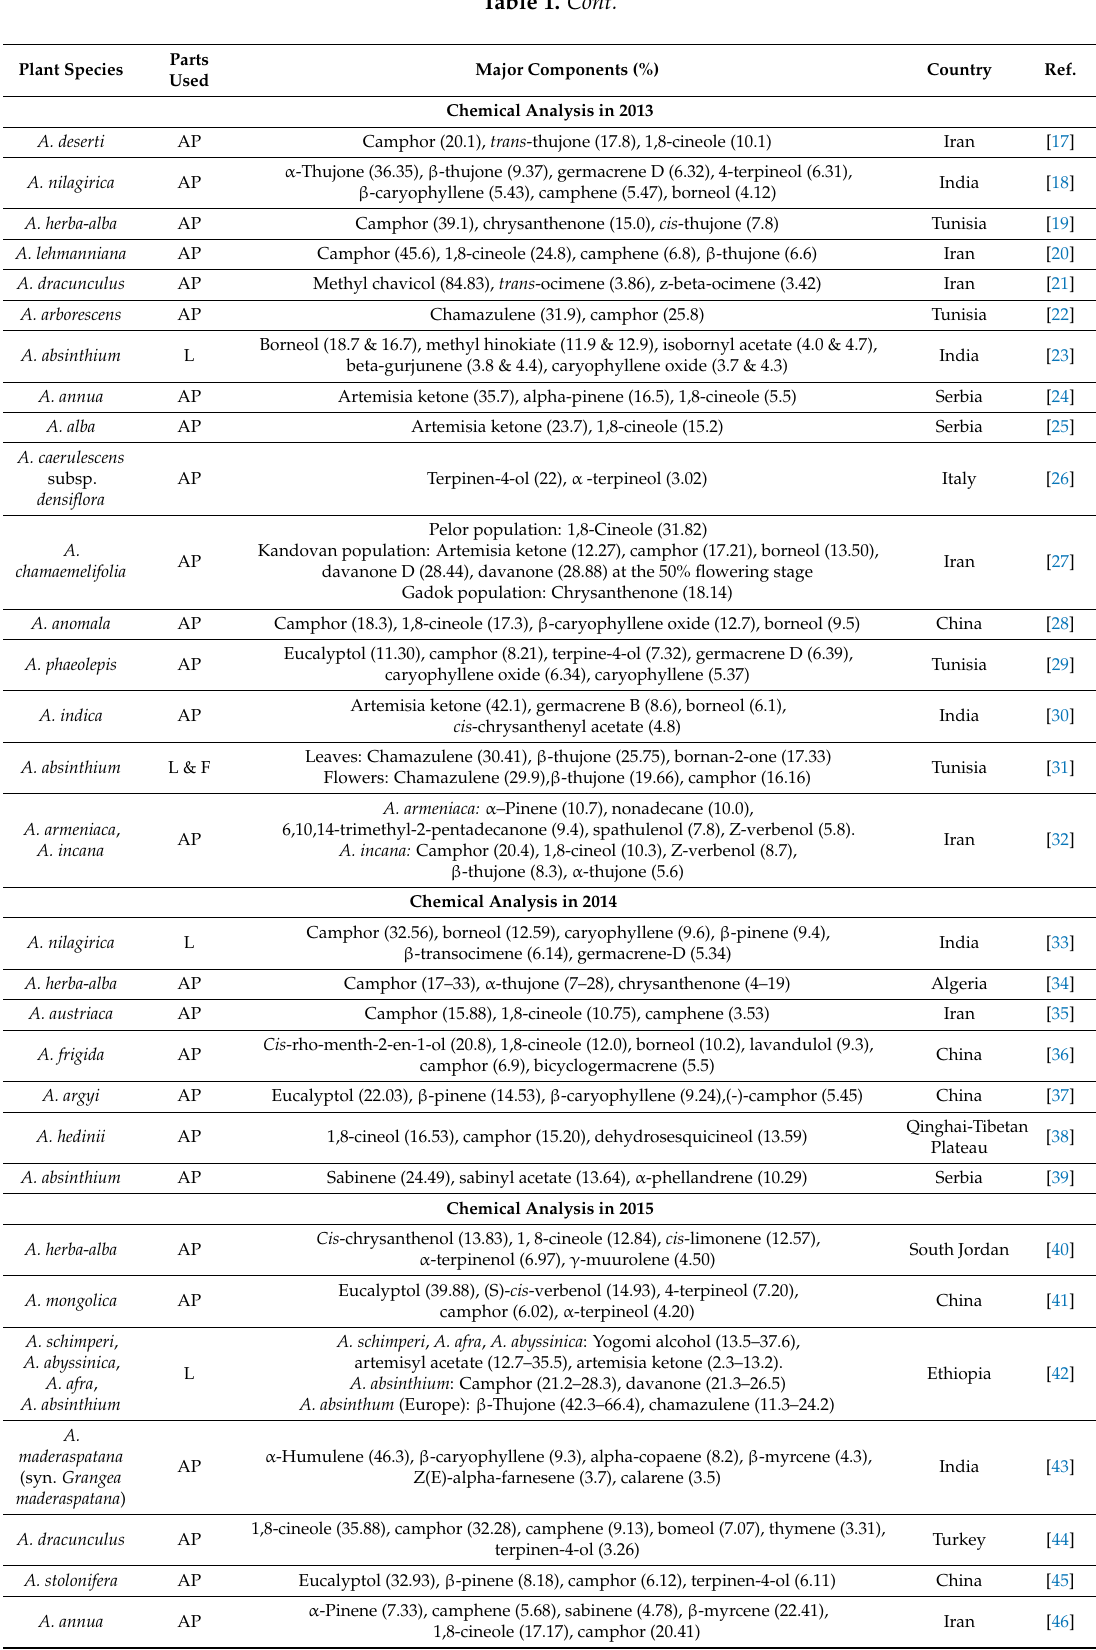
Pelor population: 1,8-Cineole (31.82) Kandovan population: Artemisia ketone (12.27), camphor (17.21), borneol (13.50), davanone D (28.44), davanone (28.88) at the 50% flowering stage Gadok population: Chrysanthenone